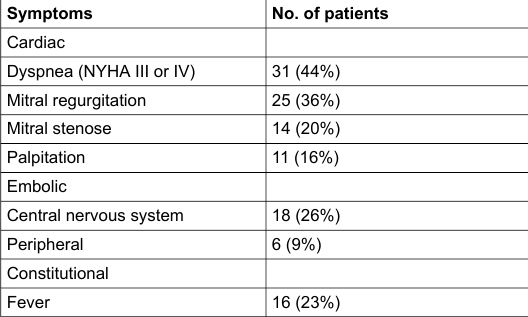
Table 2: Clinical symptoms in 70 patients with intracardiac